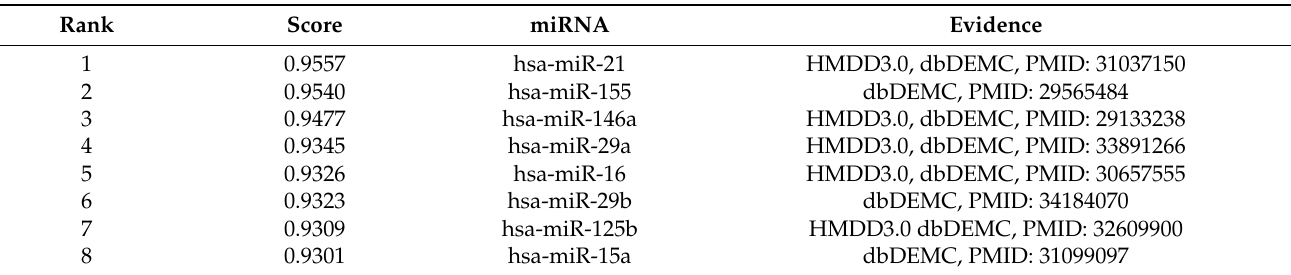
Table 3. Top-30 Predicted Associations of Liver